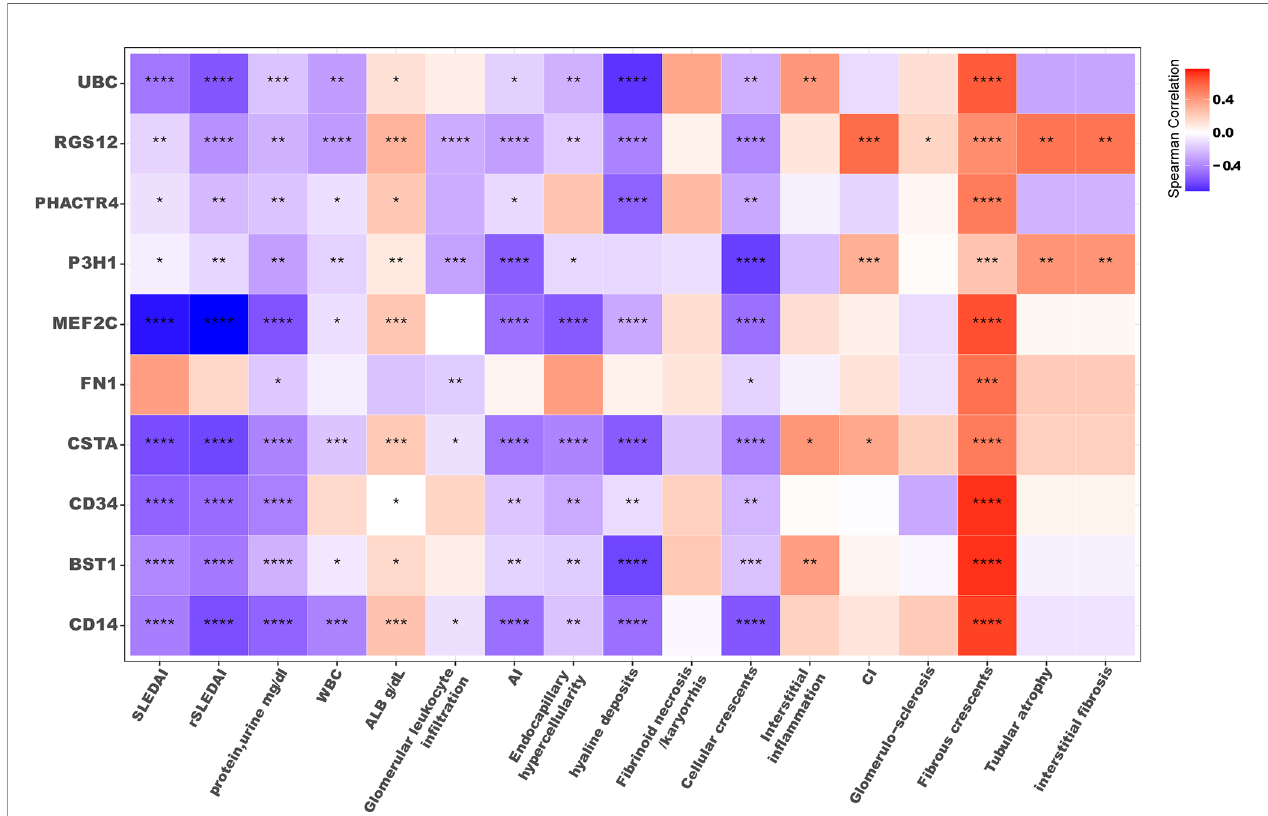
FIGURE 5 | Correlation plot of serum ICx levels with clinical parameters. The color fi lled in each square represents Spearman ’ s correlation coef fi cient value, and the corresponding signi fi cance level was indicated with asterisks: *p < 0.05, **p < 0.01, ***p < 0.001, ****p < 0.0001. SLEDAI, SLE disease activity index; rSLEDAI, renal SLE disease activity index; WBC, white blood cell count; ALB, the amount of albumin in blood; AI, renal pathology activity index, CI, renal pathology chronicity